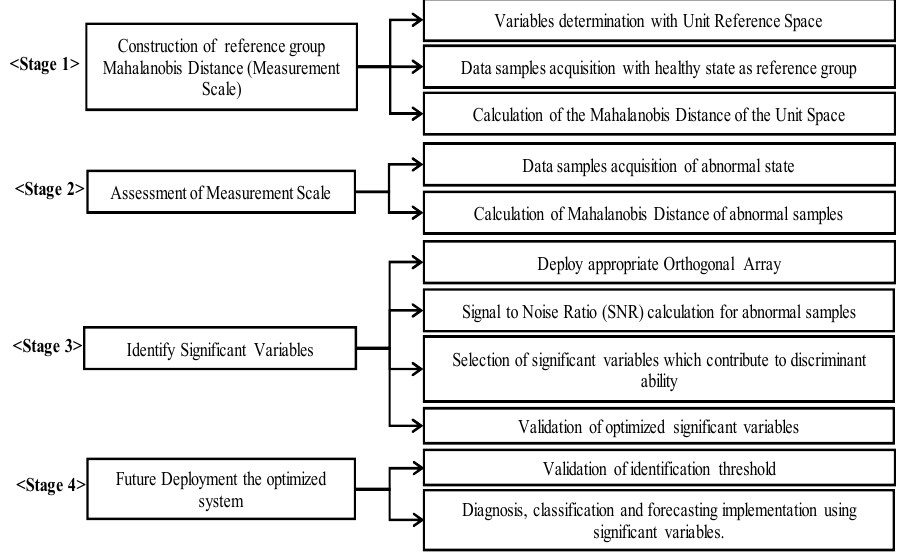
Figure 2. Fundamental four stages in Mahalanobis–Taguchi System (MTS) methodology.